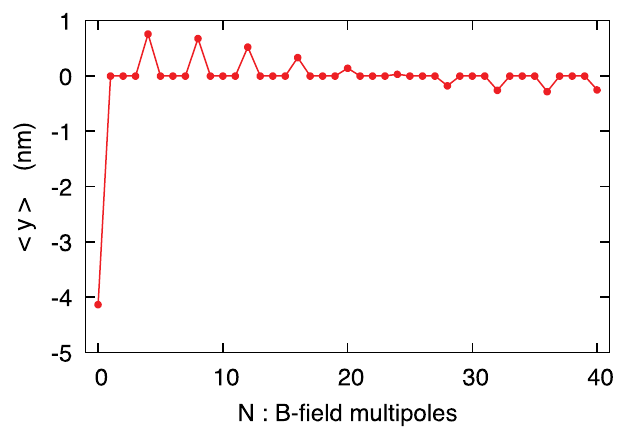
FIG. 4. The average vertical beam offset when only magnetic focusing is used, as a function of the radial B-field multipoles ( N -values).TheamplitudeofthebackgroundradialB-fieldisalways kept at 1 pT, while the quadrupole strength is kept at (cid:3) 0 . 1 T = m.